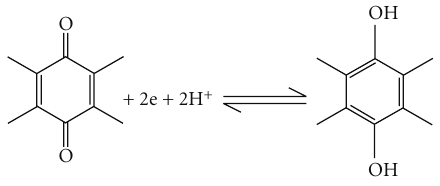
Scheme 1: Two-electron two-proton reduction of quinone in aqueous bu ff er.